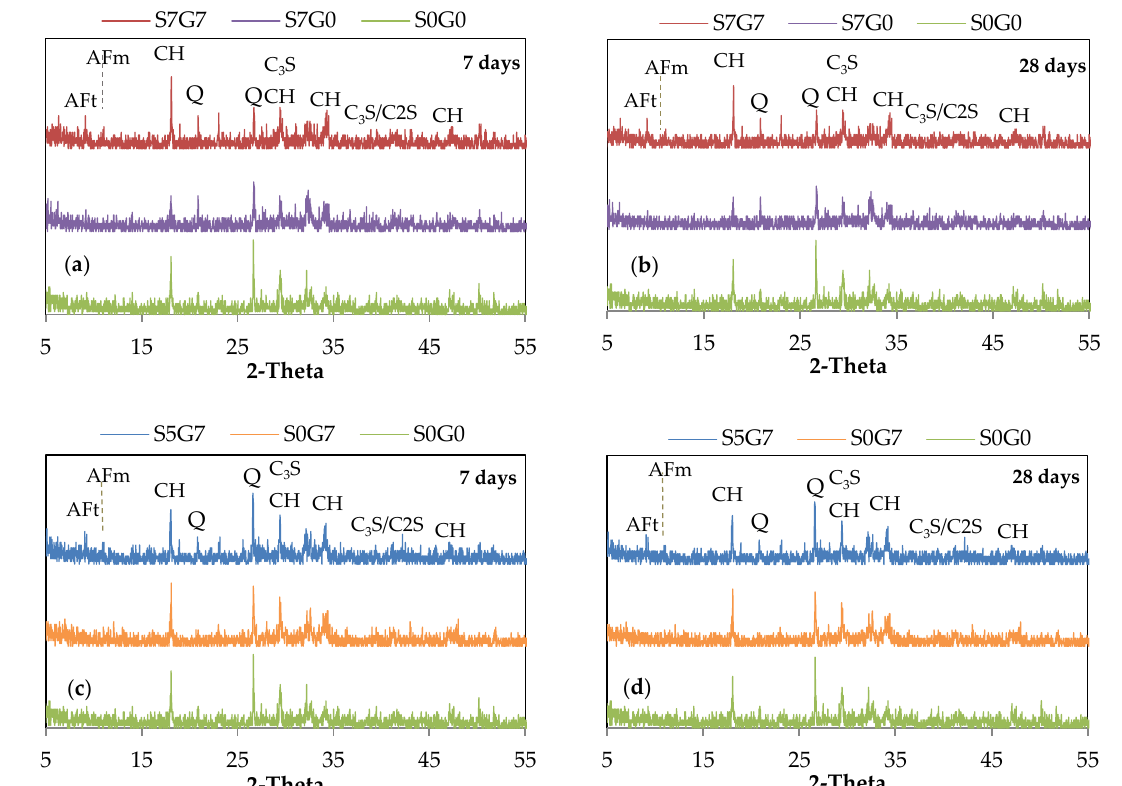
Figure 8. XRD analysis of GO/SF Cement composite: ( a ) GO effect at 7 days; ( b ) GO effect at 28 days; ( c ) SF effect at 7 days; ( d ) SF effect at 28 days.